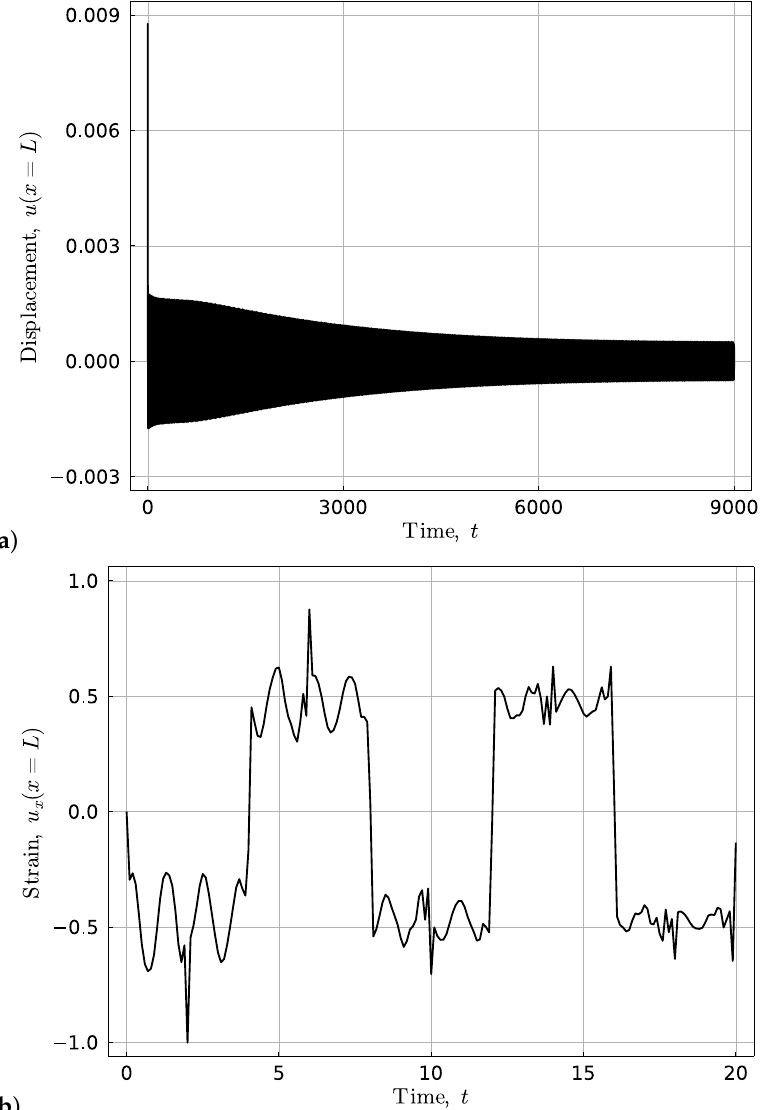
Figure 5. The optimal design of the maximal terminal displacement. The corresponding ( a ) terminal displacement and ( b ) strain responses of the rod. The response is calculated with N =